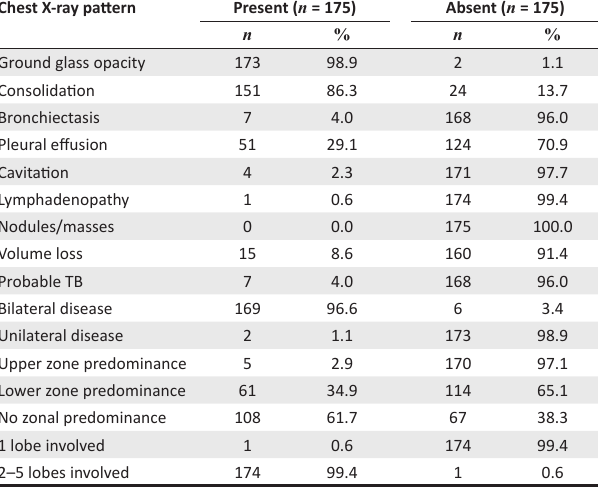
FIGURE 2: Graphical representation of patients with underlying human immunodeficiency virus and tuberculosis. TABLE 1: Summary of chest x-ray findings and patterns of disease. Chest X-ray